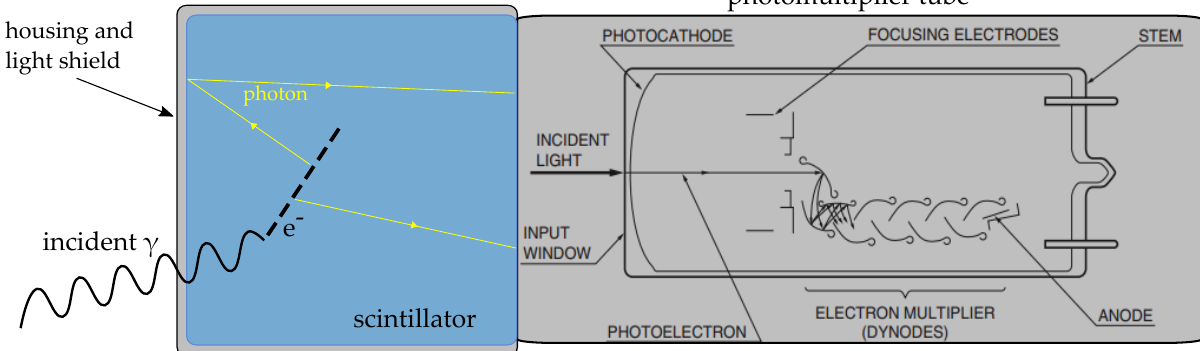
Figure 3. Illustrative diagram of scintillator detector and photomultiplier tube (PMT) (not to scale) [24]. PMT diagram reprinted, with permission, from [49]. Courtesy of Hamamatsu Photonics